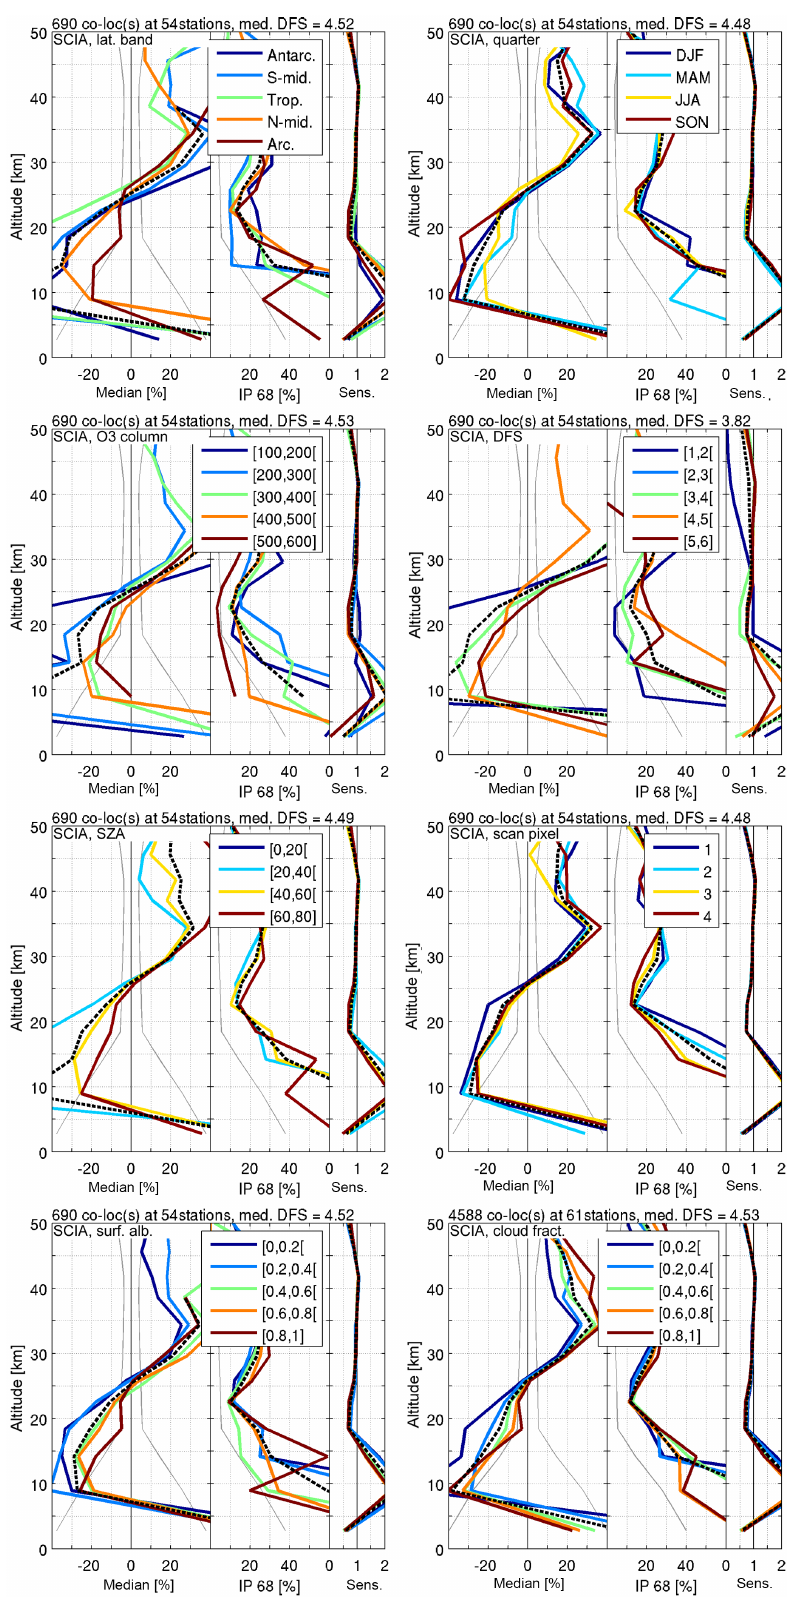
Figure 7. As for Fig. 6, but for RAL v2.14 L2 SCIAMACHY data